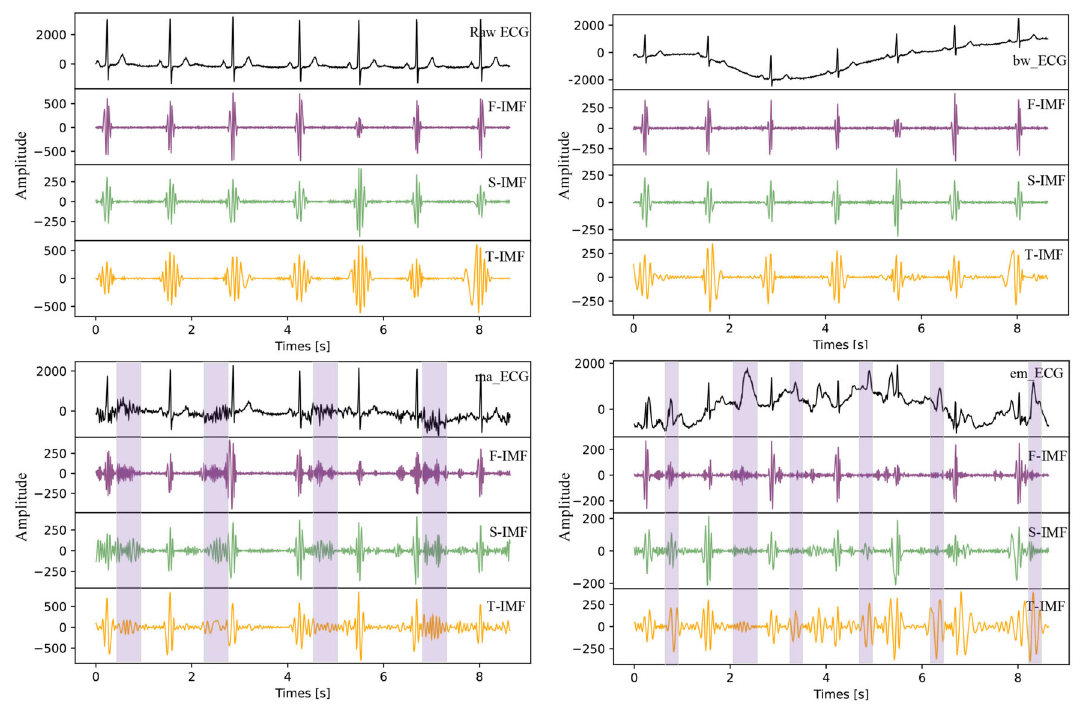
Fig. 3 The FT-IMF of clean and noisy ECG signals. The light purple area represents the features of em and ma in each IMF component. a Clean ECG signal and its FT-IMF component. b the bw-contaminated